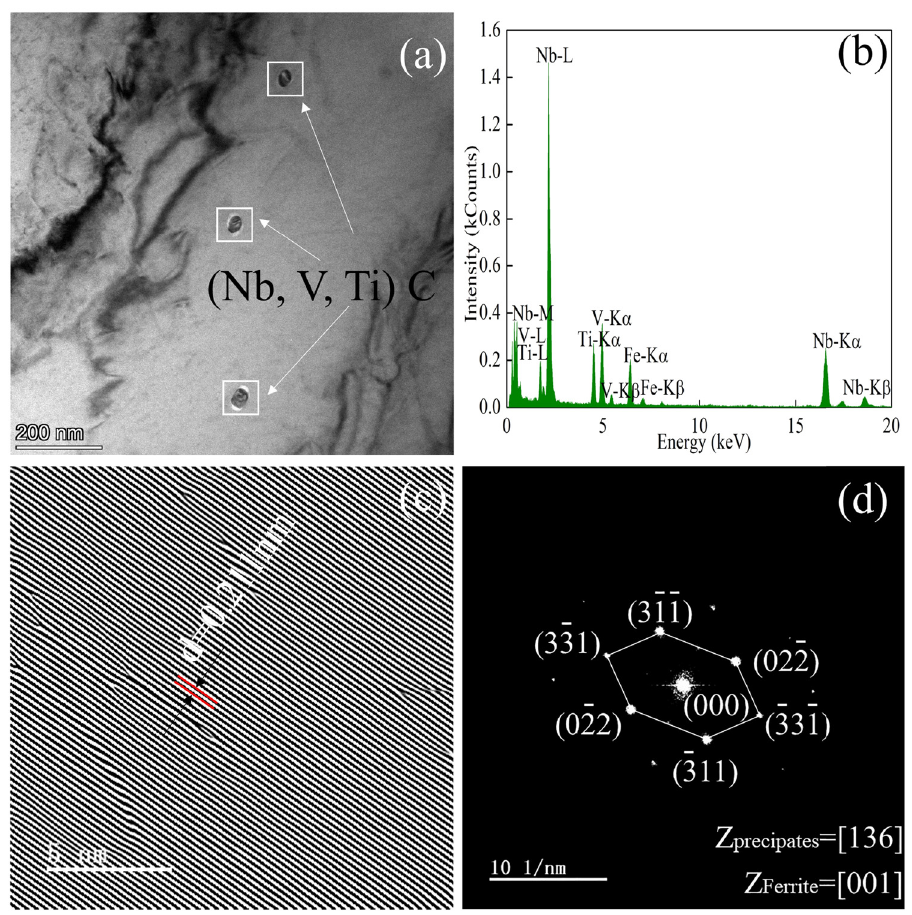
Figure 7: TEM images of ( Nb, V, and Ti ) C precipitates in the experimental rebar at 200 s. ( a ) Morphology, ( b ) EDS, ( c ) lattice fringes, and ( d ) SAED.